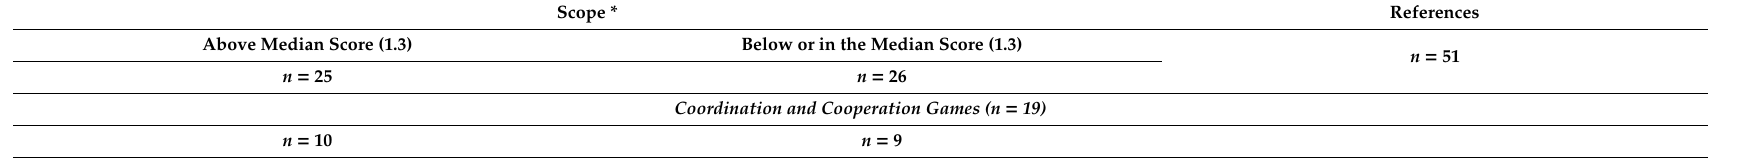
Table 1. Major results summary by topic and